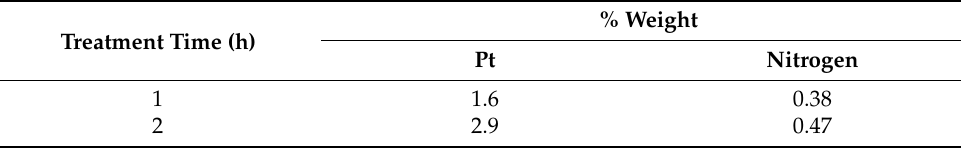
Table 1. Weight percent of Pt and N in N-TiO 2 − x /Pt (XPS analysis).